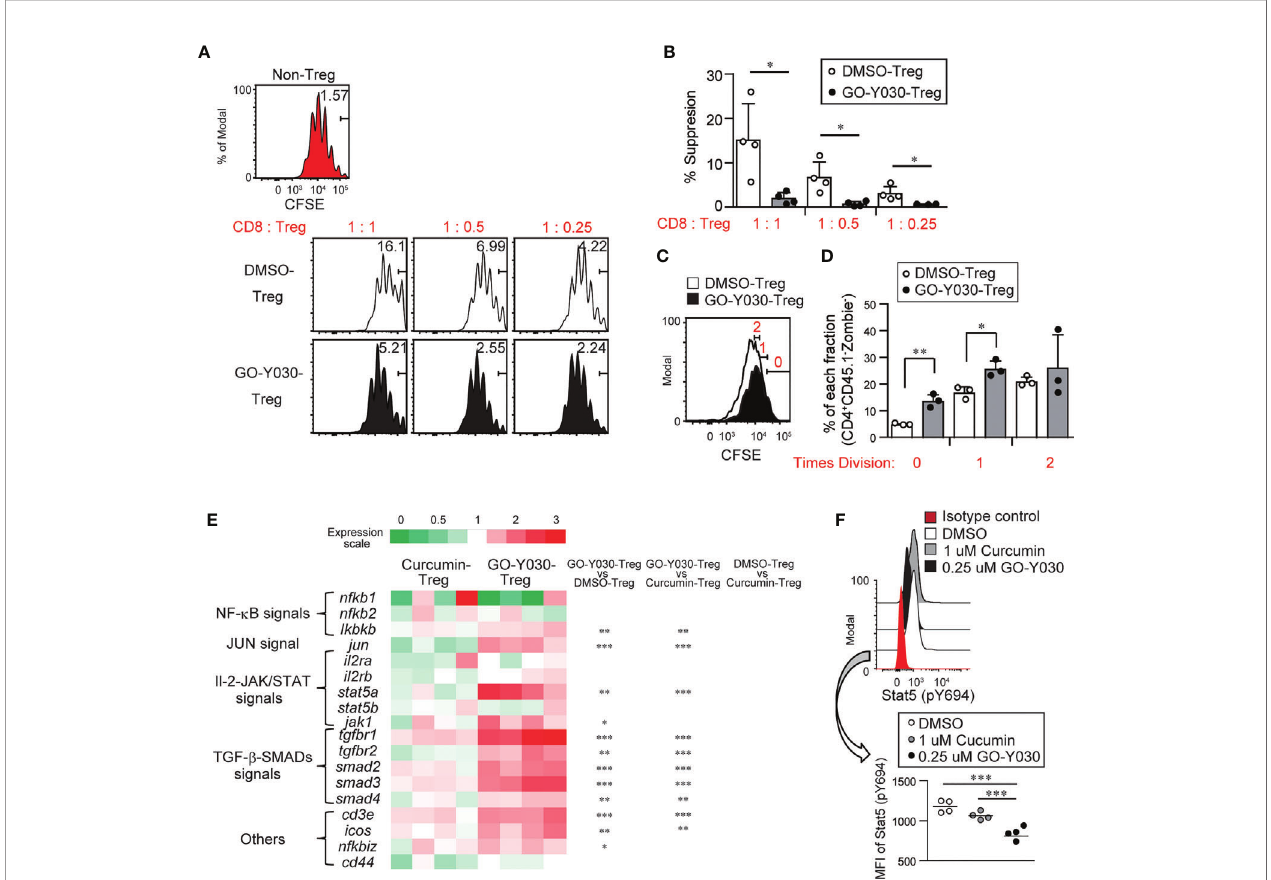
FIGURE 4 | GO-Y030-mediated suppression of Tregs. (A) Proliferation ratio of CFSE-labeled CD8 + T cells isolated from CD45.1 mice and cultured with or without CD4 + CD25 + Tregs for 72 h. The Tregs were treated with 0.25 µM GO-Y030 or DMSO control for 3 days before co-culturing. The CD8 + CD45.1 + gated cell population is shown. (B) Relative suppressive of Tregs. The percentage of non-proliferation cells in non-Tregs is set to 0%. The data are representative of at least three independent experiments. The circles stand for independent experiments. The horizontal bars represent the mean and standard deviation. (C, D) The proliferation ratio of CFSE-labeled CD4 + CD25 + Tregs 3 days after the co-culture systems is shown. The ratio of CD8 + T cells to Tregs is 1:1. The circles stand for independent experiments. The graph shows the mean and standard deviation. (E) The heat map shows the real-time quantitative RT-PCR analysis results of DMSO-, 1 uM curcumin-, or 0.25 uM GO-Y030-treated CD4 + CD25 + Tregs for 3 days. The color scale is shown at the top of the heat map. Each genes ’ expression in the DMSO-treated Tregs is as set as “ 1. ” The data are from four independent experiments. (F) Stat5 (p694) expression in cultured CD4 + CD25 + Tregs for 3 days with or without curcumin or GO-Y030. The data show the gated CD4 + Zombie - population. The graph shows the mean and standard deviation. The Student ’ s t-test (B, D) or one-way ANOVA with post-hoc Tukey ’ s multiple comparisons test (E, F) was used. *P< 0.05, **P < 0.01, ***P <